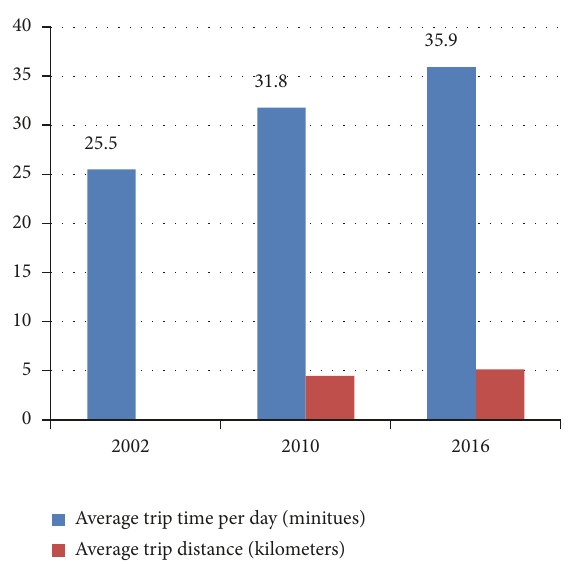
Figure 2: Average trip time and distance per day in the 3 traffic surveys of Qingdao.